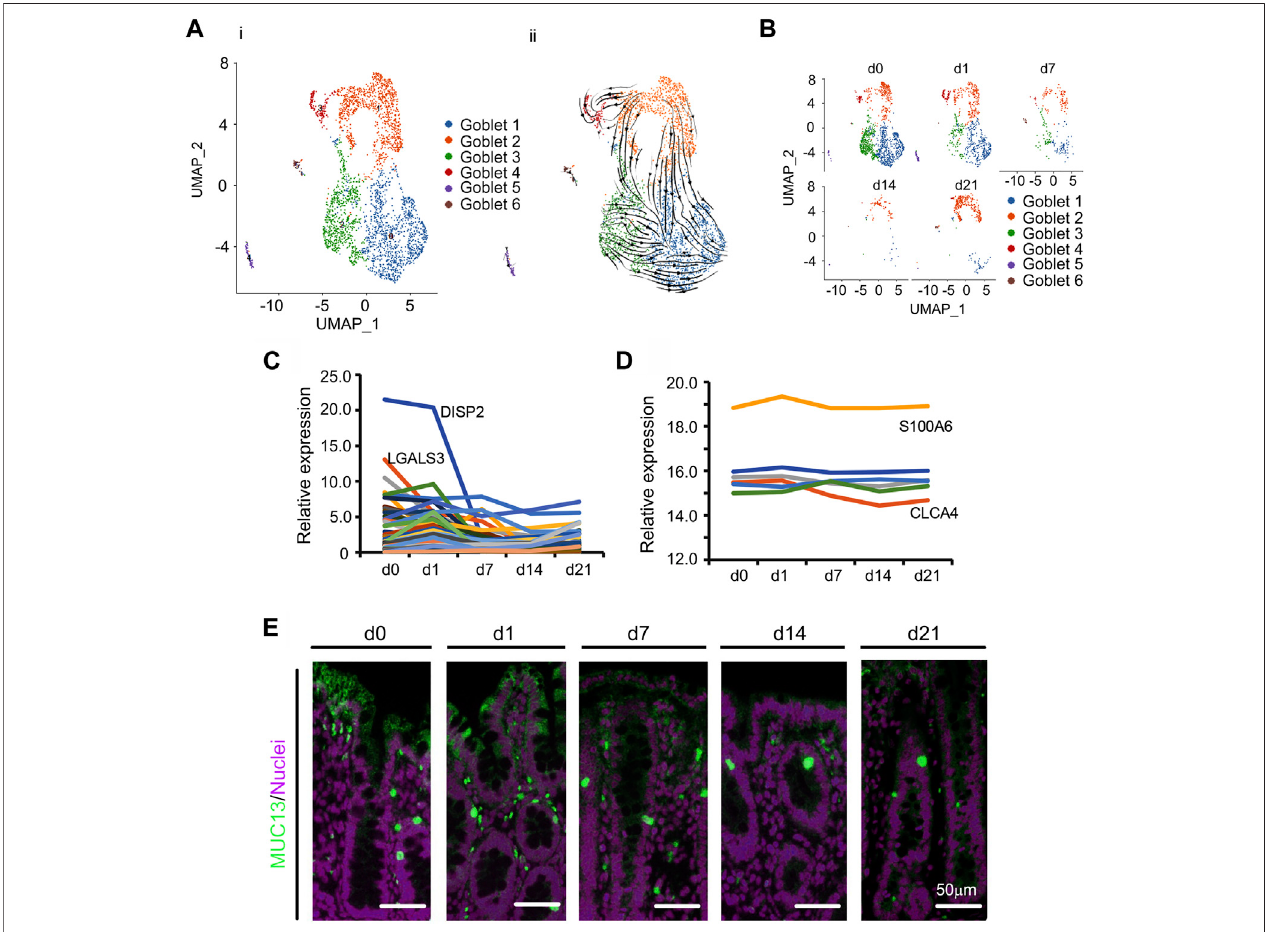
FIGURE4| Decrease ingoblet cellsofpigletcecumduringtheneonatalwindow. (A) Celltypeclustersforgobletcellsforthecellstogetherfromthe fi vetimepoints byUMAP.(i)UMAPofgobletsinglecells(points),coloredbyclusterassignment.(ii)RNAvelocityvectorprojectiononUMAPplot(Thearrowindicatedthedevelopmental trend). (B) Decreaseingobletcellpopulationduringdevelopment(fromd0tod21). (C) Therelativeexpressionpatternofthetop50speci fi callyexpressedgenesingoblet cells. The gene level was based on the expression of each gene in all the cell, and it is relative level from scRNA-seq analysis. The Y-axis presents the relative expression,and X-axis shows thetime points. (D) Therelativeprotein levelsofsomeofthetop 50speci fi cally expressed genesfrom theproteomics analysis.TheY-axis presents the relative expression, and X-axis shows the time points. (E) Protein levels of MUC13 in different samples at different time points according to IHF. Scale bar: 50 μ